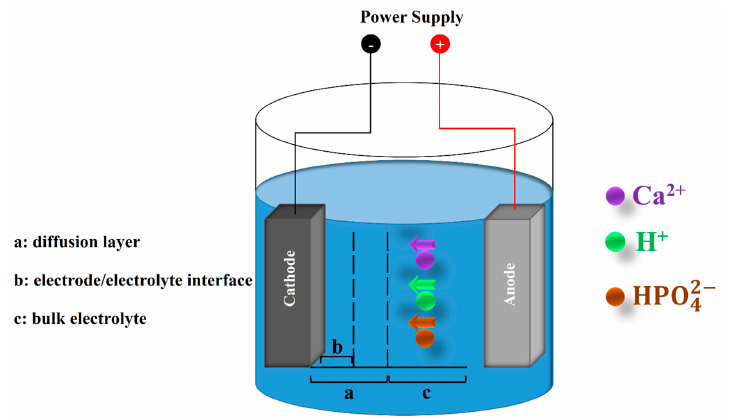
Figure 6. Schematic illustration of the proposed model for movement and deposition of the ions during the electrodeposition process. Calcium ions react with HPO (cid:2872)(cid:2870)(cid:2879) and PO (cid:2872)(cid:2871)(cid:2879) ions to form various calcium phosphates phases, including DCPD, OCP, HAp, and TCP [108,109].